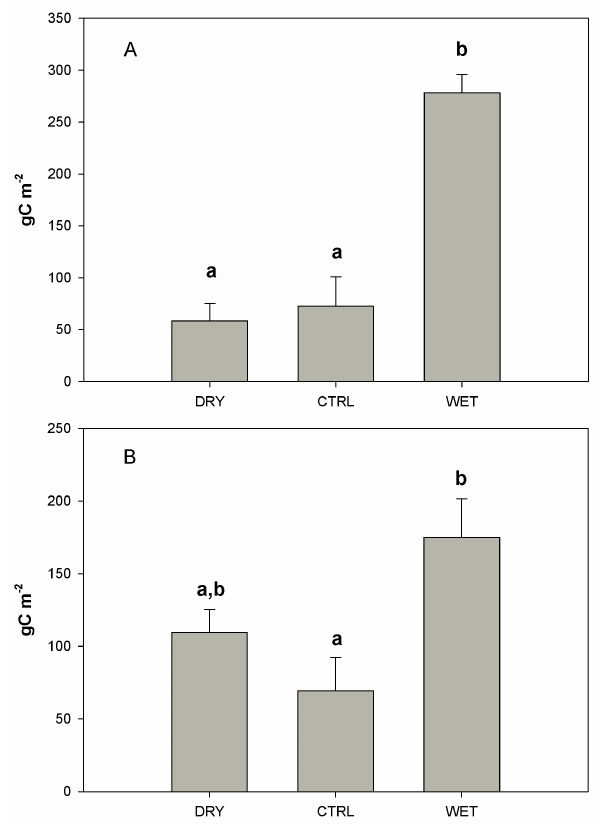
Fig. 3. Net plant-derived SOC, as estimated by the C 4 soil cores approach, after one year of incubation in control, dry and wet plots, for (a) the 0–15cm and (b) the 15–30cm depth layer. Values are means, with bars as standard errors. Different letters indicate a sig- nificant difference among treatments ( p < 0 .